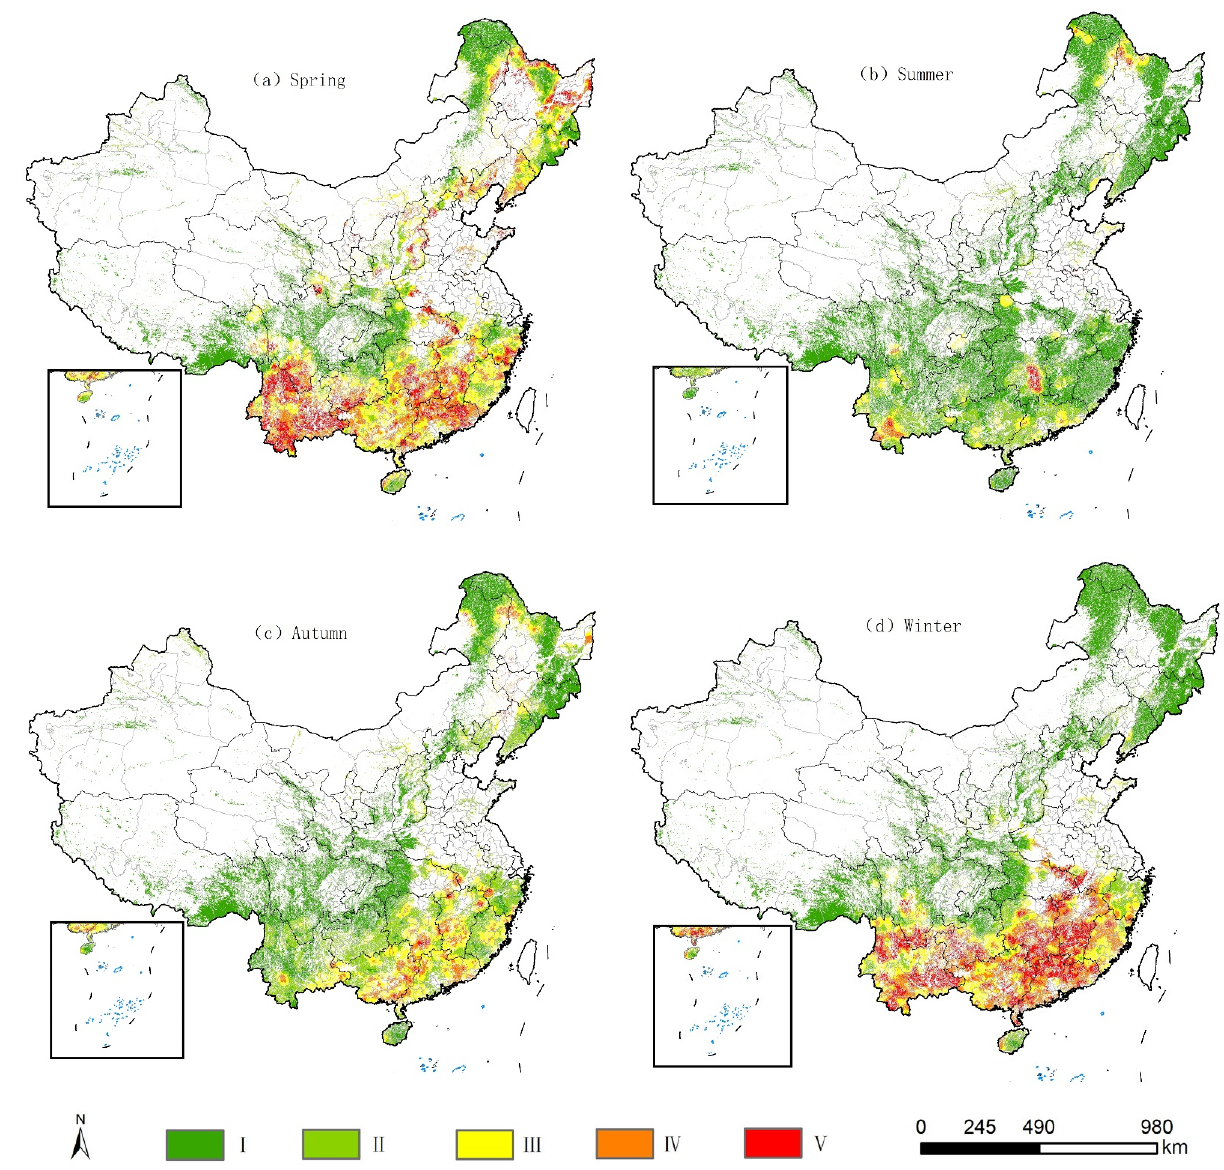
Figure 6. Seasonal Chinese FF zoning maps (spring, summer, fall, and winter). China’s FF risk prediction and zoning show obvious differences in distribution pat- terns because of the influence of many factors. Because of China’s vast land area, differ- ent regions have great differences in topography, climate, and other natural conditions, and the accompanying human activities are also different, which lead to large regional differences in the risk of FFs. Northeast China (e.g., the cities of Heihe, Qitaihe, and Dandong) is rich in forest resources, and there is a typical monsoon climate every spring and fall; the spring climate is dry, and there are strong winds, less precipitation, and low relative humidity in the fall, which increases the probability and duration of fire out- breaks [66]. Parts of the northeast and Inner Mongolia are in high-risk areas that are flat. Be- cause of Siberia, the spring and fall seasons there are windy and inconvenient for trans-